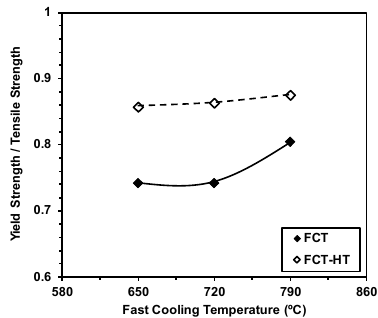
Figure 4. Evaluation of the effect of the induction heat treatment and the FCT on the yield/tensile strength ratio.